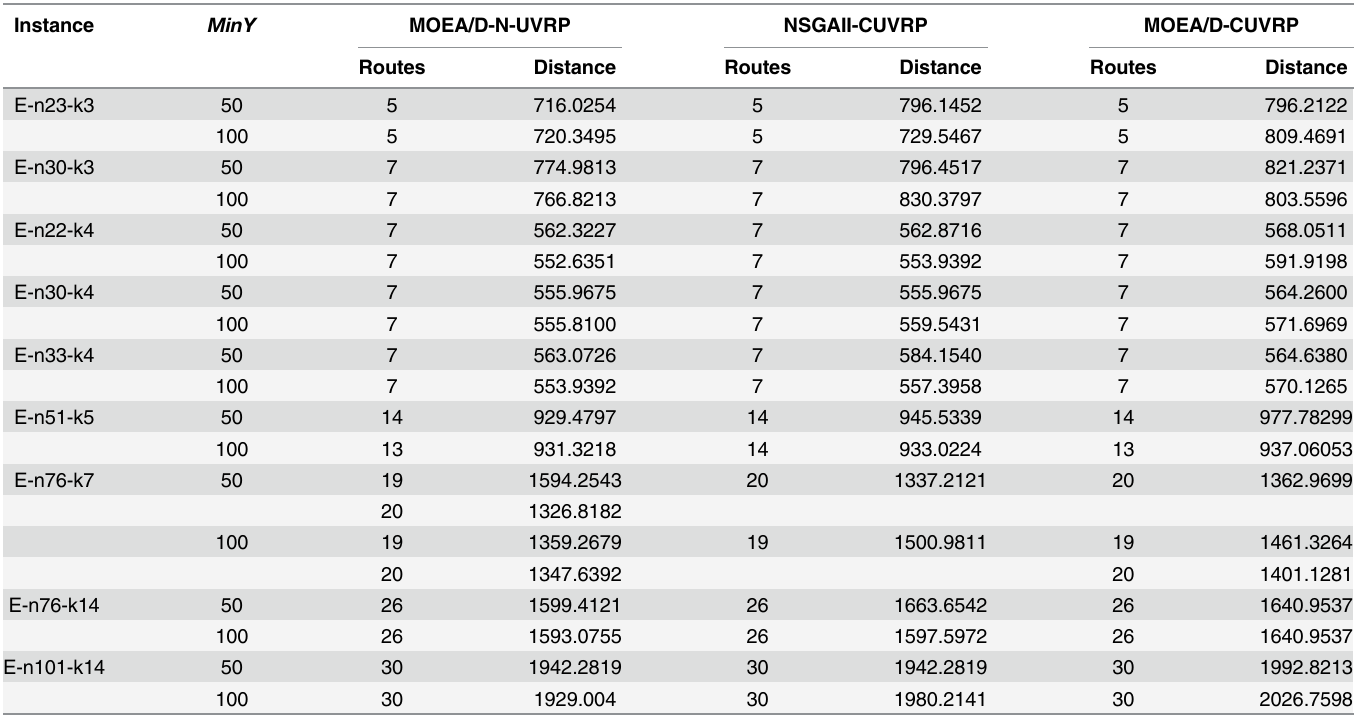
Table 7. Computational results of numerical